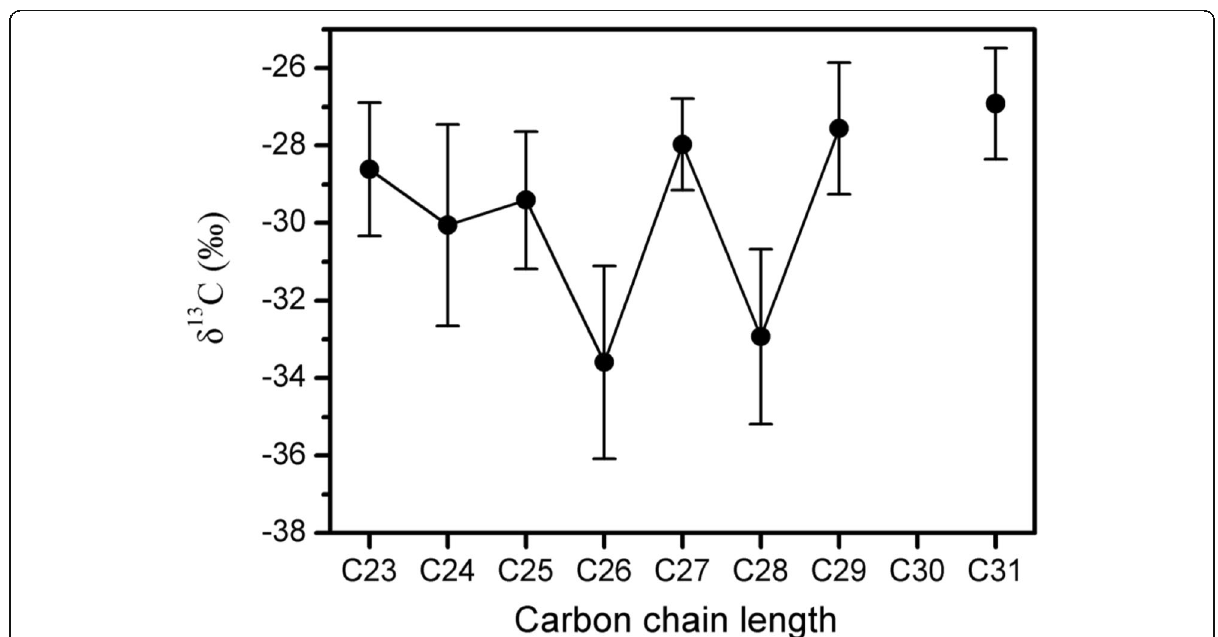
Fig. 5 The average δ 13 C values of n -alkanes. The error bars represent 1 standard deviation of 12 samples in the core R23 (not analytical